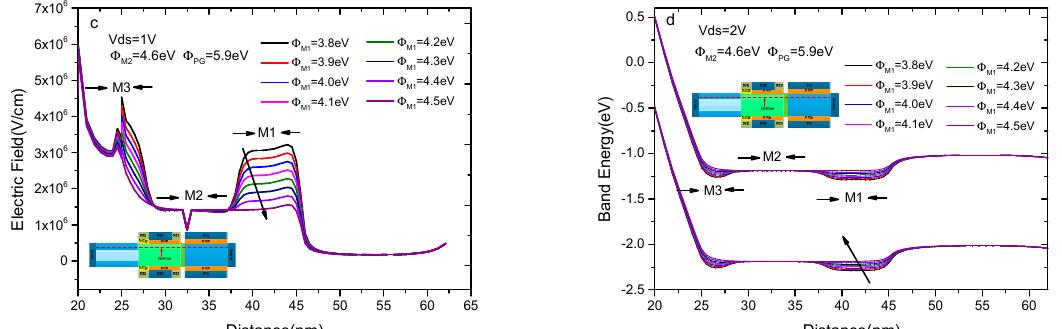
Figure 9. ( a ) Simulated log scale and linear scale transfer characteristics of DMMG-HJLTFET with different auxiliary gate work function ( Φ M1 ); ( b ) the potential distribution at the surface with different auxiliary gate work function ( Φ M1 ); ( c ) the distribution of electric field at the surface with different auxiliary gate work function ( Φ M1 ); ( d ) the variation of ON-state energy band with different auxiliary gate work function ( Φ M1 ).